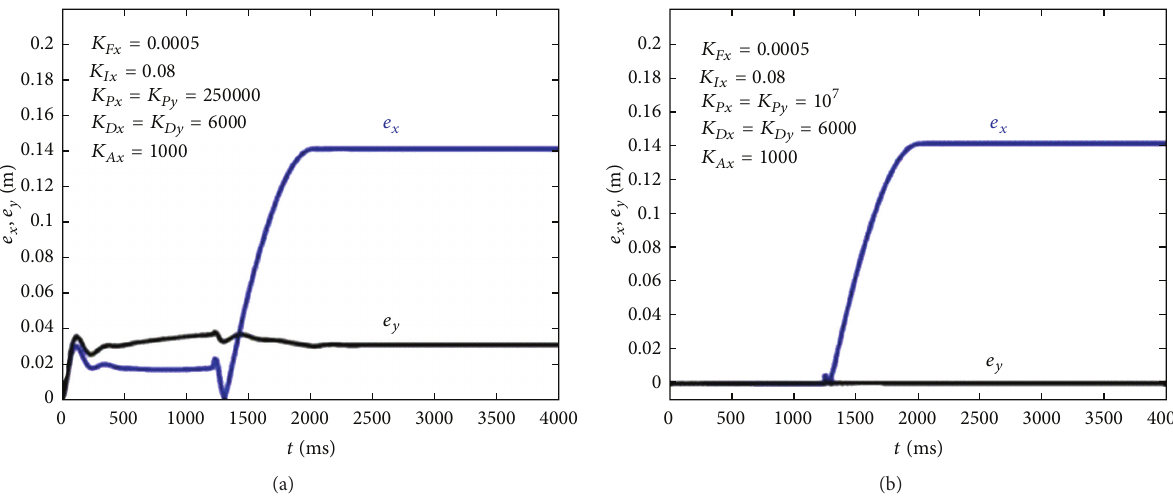
Figure 23: End-Effector error position value (m) varying the 𝐾 𝑃 gain in the PI system: (a) 𝐾 𝑃 = 250000 ; (b) 𝐾 𝑃 = 10 7 .